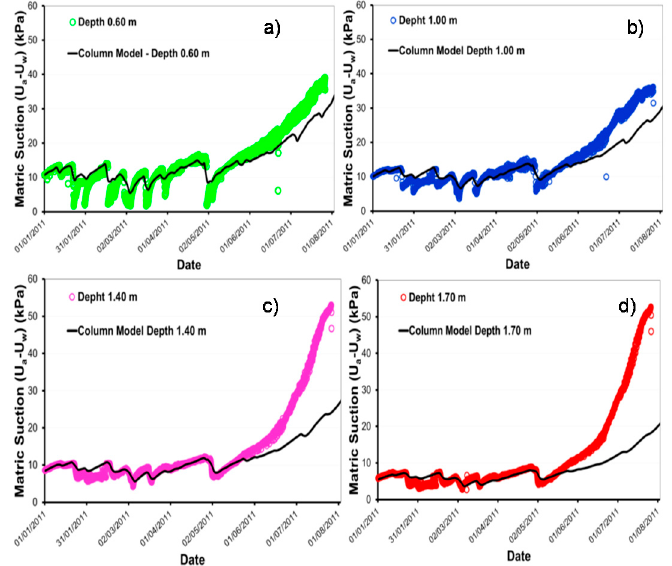
Figure 12. The Round Robin Test: comparison of computed and measured suction at a depth of ( a ) 0.60, ( b ) 1.00, ( c ) 1.40 and ( d ) 1.70 m.